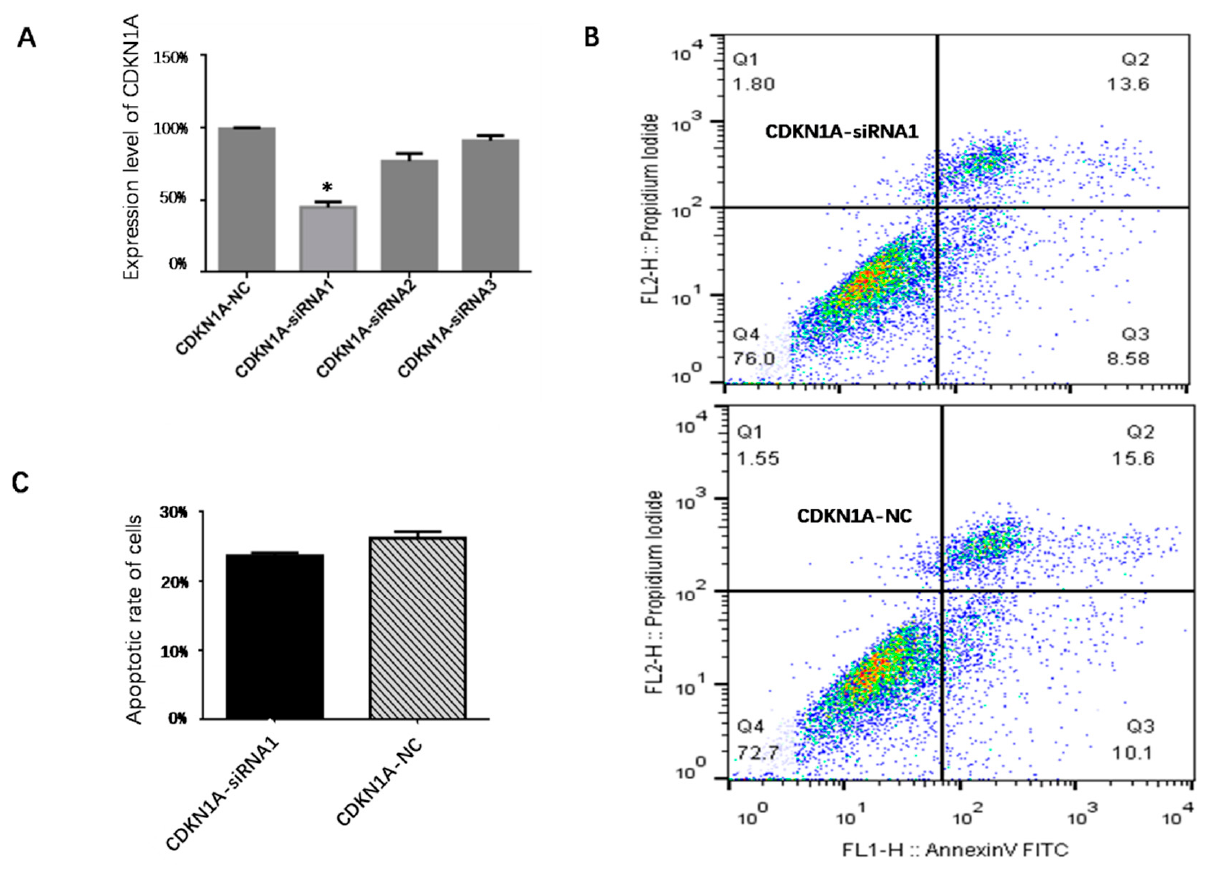
Figure 10. ( A ) Quantification map of transfection efficiency, * p < 0.05. ( B ) Effects of CDKN1A -siRNA1 and CDKN1A -NC on pGC apoptosis by flow cytometry after transfection. ( C ) Quantitative histogram of the apoptotic rate after transfection of CDKN1A -siRNA1 and CDKN1A -NC on pGC apoptosis. All experiments were repeated 3 times.